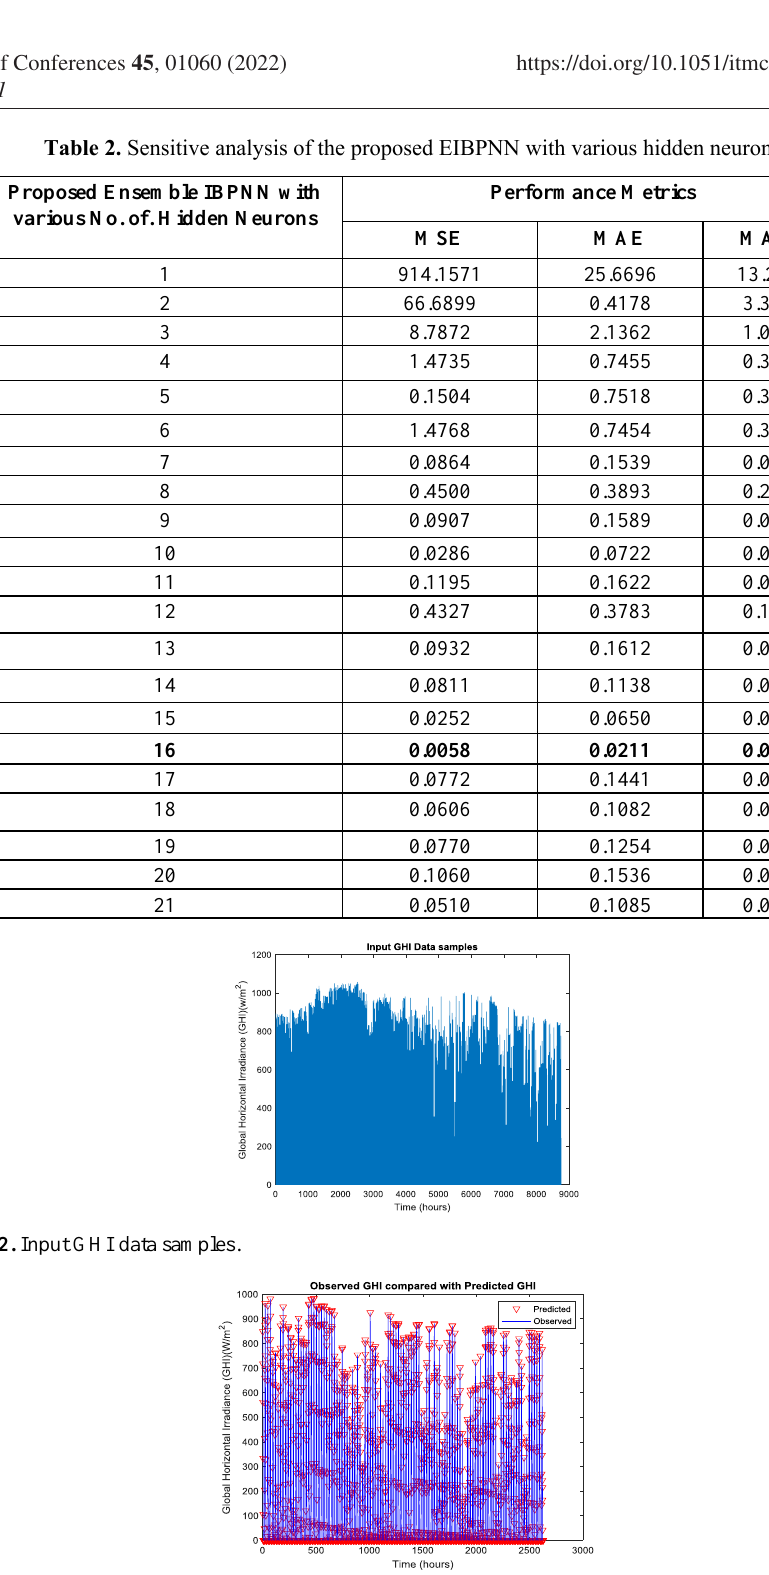
Fig. 3. Observed GHI compared with Predicted